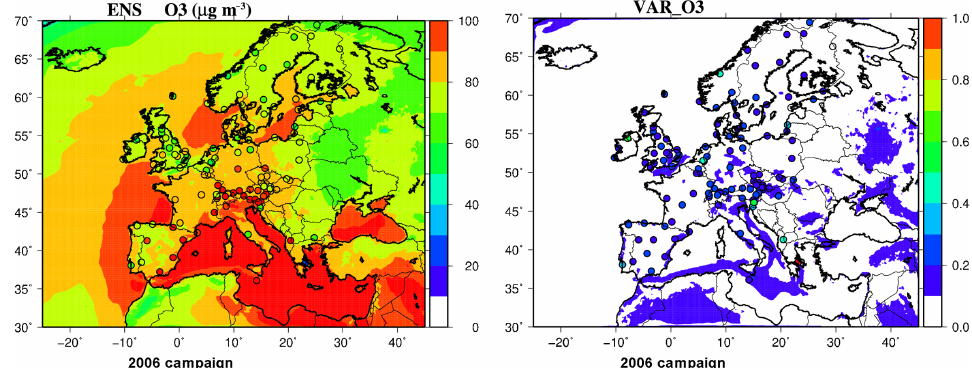
Figure 5. Left column: mean ozone concentrations (µgm − 3 ) of the ensemble (ENS) for the 2006 campaign with corresponding observations (coloured dots). Right column: coefficient of variation of models (no unit) constituting the ensemble with corresponding normalized root mean square errors of the ensemble (coloured dots). Red colour is assigned for values exceeding the colour scale.